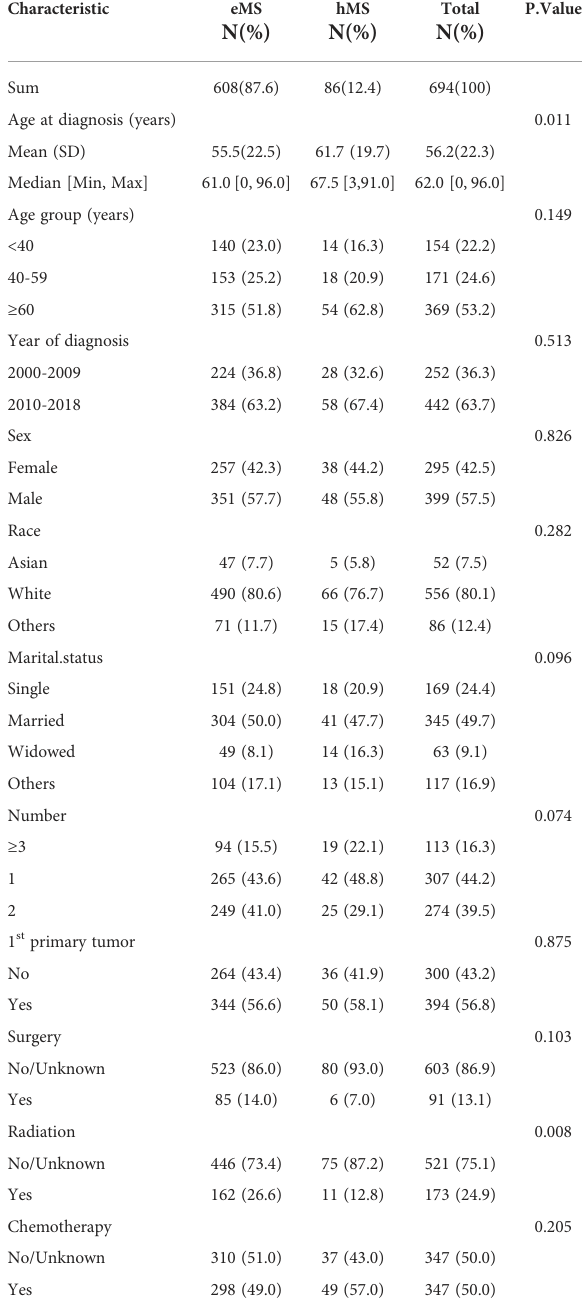
TABLE 1 Baseline characteristics of patients diagnosed with MS from the SEER